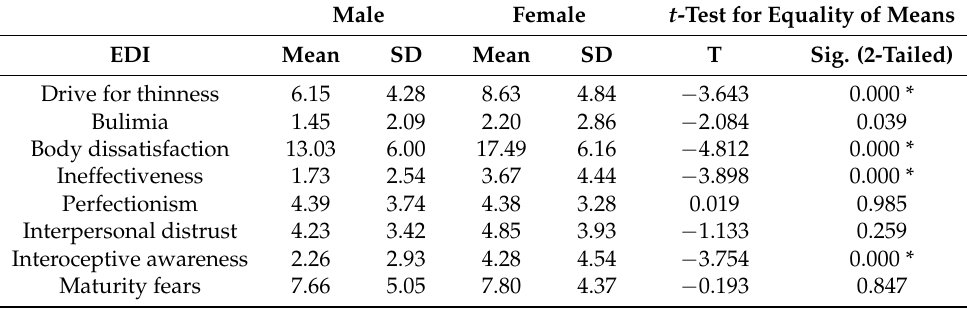
Table 1. Gender differences at the Eating Disorder Inventory—EDI. Male Female t -Test for Equality of